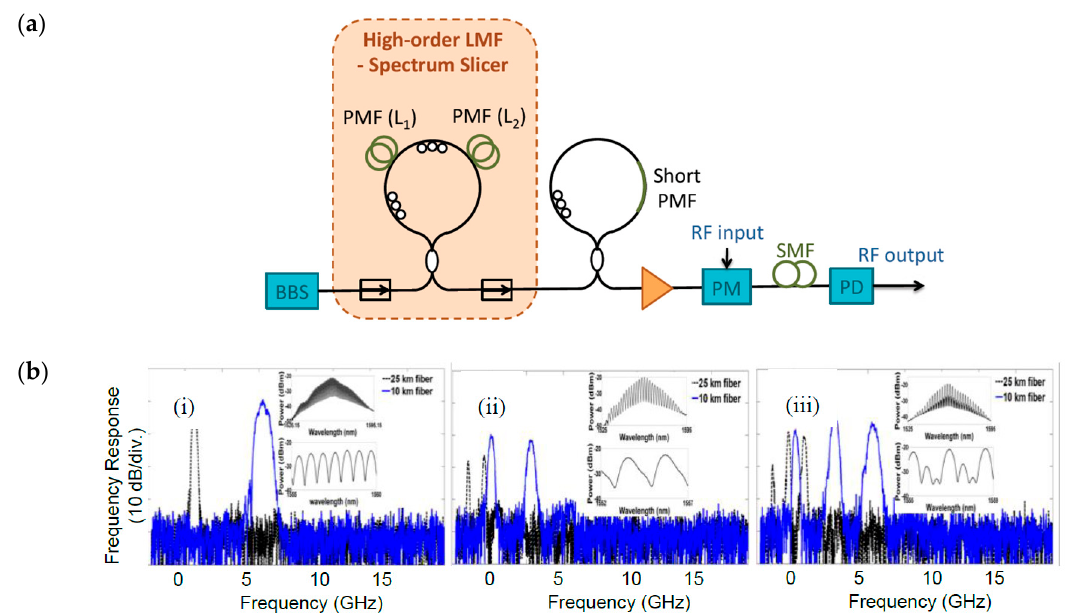
Figure 6. ( a ) Experimental setup of the loop mirror (LMF) based three-passband microwave photonic filter. BBS: broadband light source; PMF: high-birefringent fiber; PM: phase modulator; SMF: standard single mode fiber; PD: photodetector. ( b ) Resultant filter response with reconfigurable passbands (with the courtesy of Dr. Y. Jiang): ( i ) one passband, ( ii ) two passbands, ( iii ) three passbands.